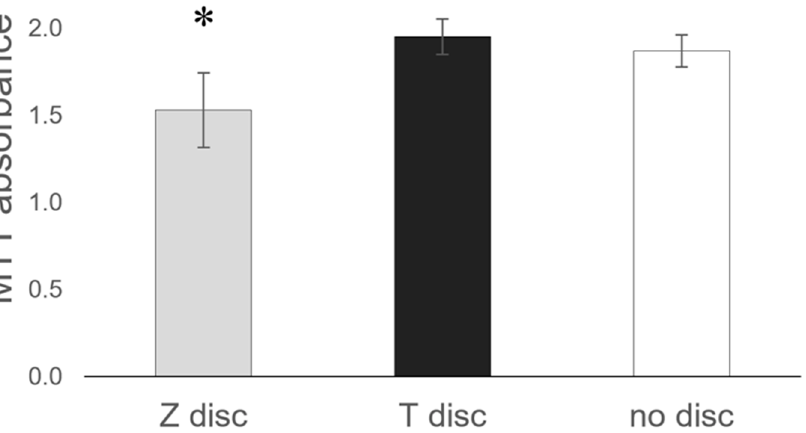
Figure 5. Comparison of the Z and T discs in MTT assay. MG-63 cells were incubated on discs for 72 h, then the MTT assay was performed. Values represent mean ± SD, * p < 0.05. Three independent experiments were performed in triplicates.